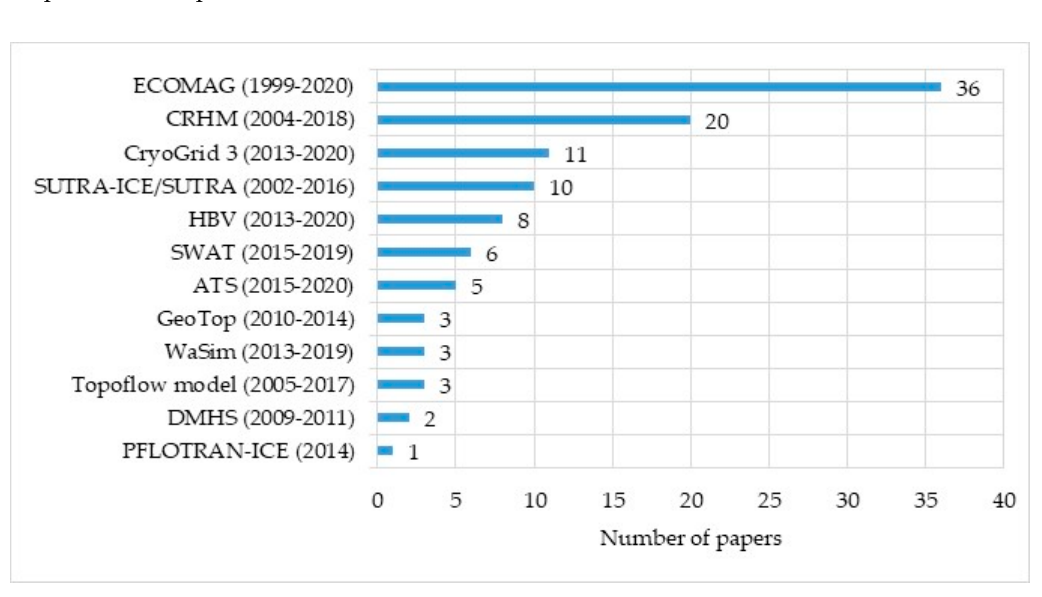
Figure 2. Number of recent publications on applications of hydrological/cryo-hydrogeological models in the Arctic (found via https://www.scopus.com/).